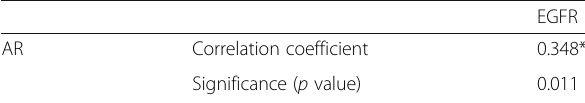
Table 1 Pearson ’ s correlation of protein expression between AR and EGFR